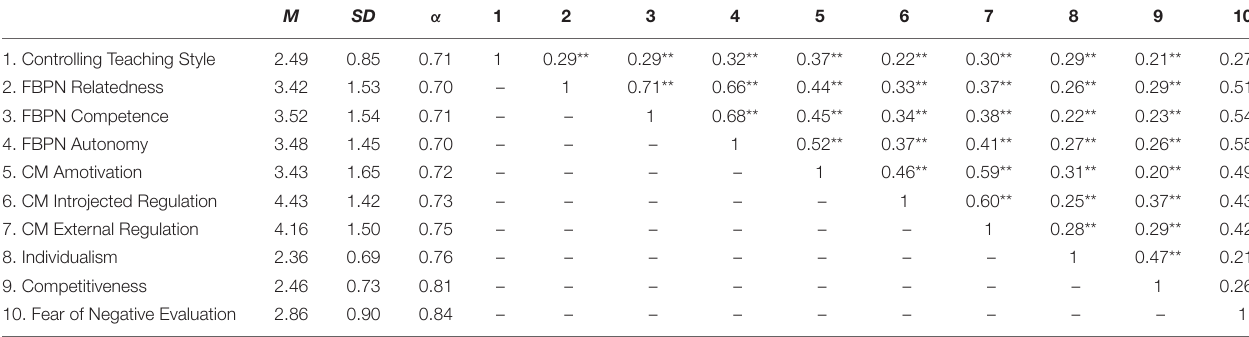
TABLE 1 | Mean, standard deviation and correlations between